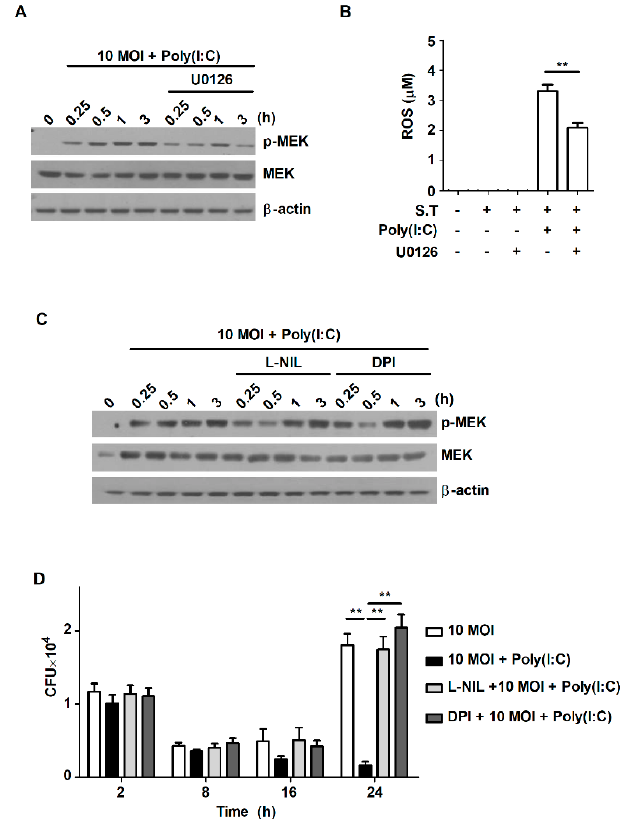
Figure 5. Poly(I:C) suppresses intracellular bacterial growth by promoting ROS production via MEK1/2-mediated signaling in S . Typhimurium-infected cells. ( A , B ) RAW264.7 cells were pretreated with U0126 for 1 h and then infected with S . Typhimurium in the presence or absence of poly(I:C). ( A ) Total cell lysates were assessed via Western blot analysis to detect phospho-MEK1/2 at the indicated timepoints. ( B ) ROS production was determined in cell culture supernatants. ( C , D ) RAW264.7 cells were pretreated with DPI or L-NIL for 1 h and then infected with S . Typhimurium in the presence or absence of poly(I:C). ( C ) Total cell lysates were assessed via Western blot analysis to detect phospho-MEK1/2 at the indicated timepoints. ( D ) Intracellular growth of S . Typhimurium was assessed via CFU assay. The data are presented as the mean ± SD ( n = 3), and were